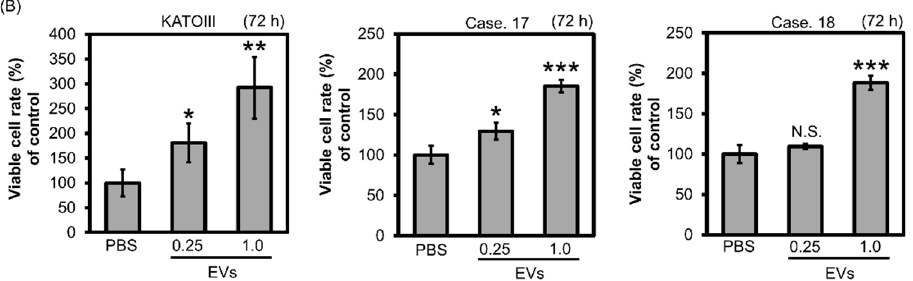
Figure 6. GJ-EVs from GC patients promoted the growth of fibroblast cells. Human normal fibroblastic ASF-4 cells were exposed to EVs extracted from KATOIII or the GJ of GC patients. ( A ) GJ-EVs (case 7 ′ sample) were dyed with a cell-permeating nucleic acid selective for RNA. The photographs were taken at 24 h after treatment. Left panel, control (phosphate-buffered saline (PBS)); Middle panel, GJ-EVs; Right panel, 3D view of the middle panel. RNA of GJ-EVs is dyed green; cell membrane, red; and nuclei, blue. Two cases of GJ-EVs were examined; ( B ) The cell growth of EV-treated ASF-4 cells. PBS was used as a control substance. The density of EVs was adjusted to 5000 (1.0) and 1250 (0.25) μ g/mL. Two cases of GJ-EVs and EVs from KATOIII cells were examined. The effects were examined at 72 h after treatment. Results are presented as the mean ± standard deviation (SD);